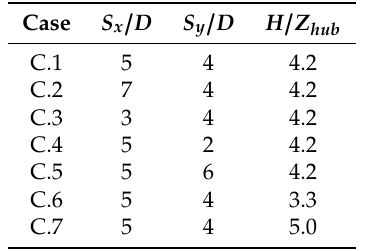
Table 1. Summary of the simulated cases.